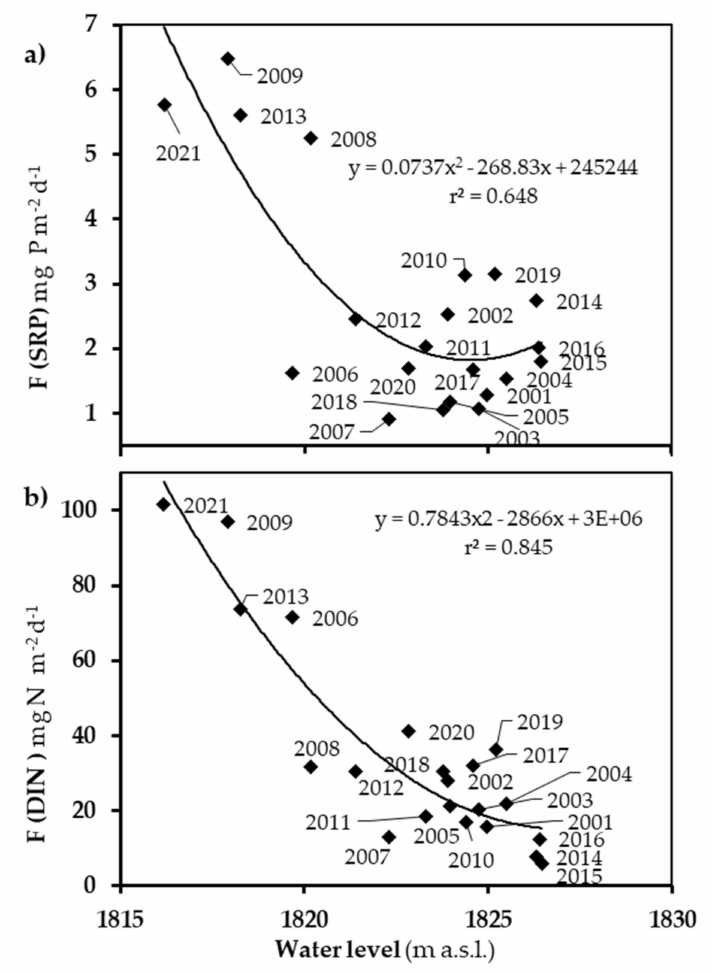
Figure 6. Mean rates of nutrient vertical flux (F) of ( a ) SRP (mg P m − 2 day − 1 ) and ( b ) DIN (mg N m − 2 day − 1 ) plotted against the annual minimum water level (m a.s.l) of VB during